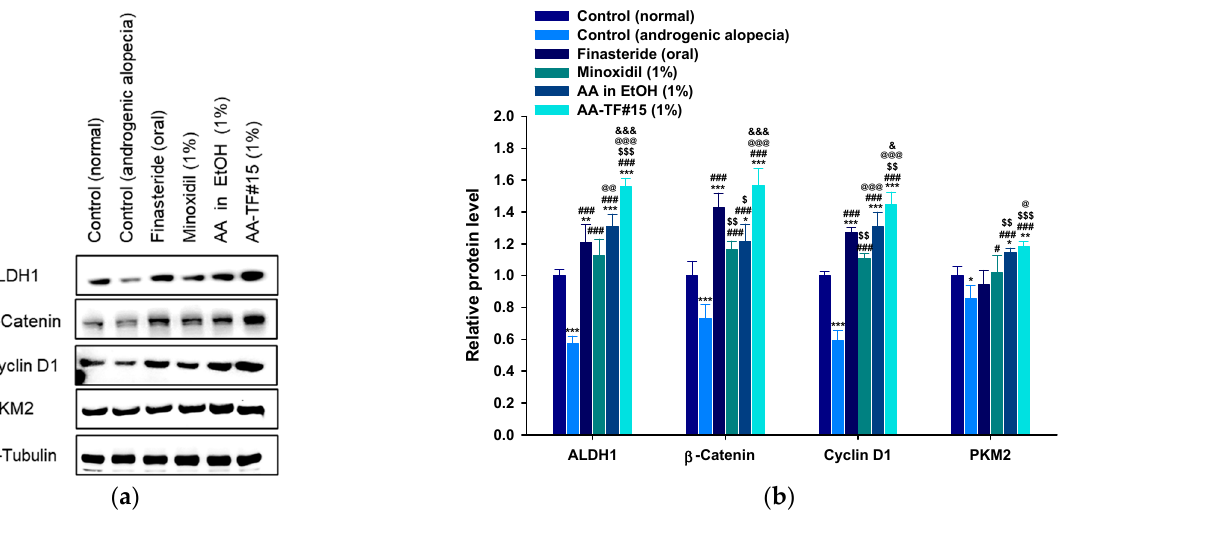
Figure 8. Expression of ALDH-1, β -catenin, cyclin D1, and PKM2 proteins in the dorsal skin of mice at 18 days after treatment: ( a ) Western blot analyses of ALDH-1, β -catenin, cyclin D1, and PKM2 proteins; ( b ) Relative protein levels of ALDH-1, β -catenin, cyclin D1, and PKM2 in the skin using α -tubulin and actin as loading controls. * p < 0.05, ** p < 0.01, *** p < 0.001 compared to control (normal); # p < 0.05, ### p < 0.001 compared to control (androgenic alopecia); $ p < 0.05, $$ p < 0.01, $$$ p < 0.001 compared to orally administered finasteride; @ p < 0.05, @@ p < 0.01, @@@ p < 0.001 compared to minoxidil (1%); & p < 0.05, &&& p < 0.001 compared to AA in EtOH (1%). Values are presented as mean ± SD ( n = 4 for each group).